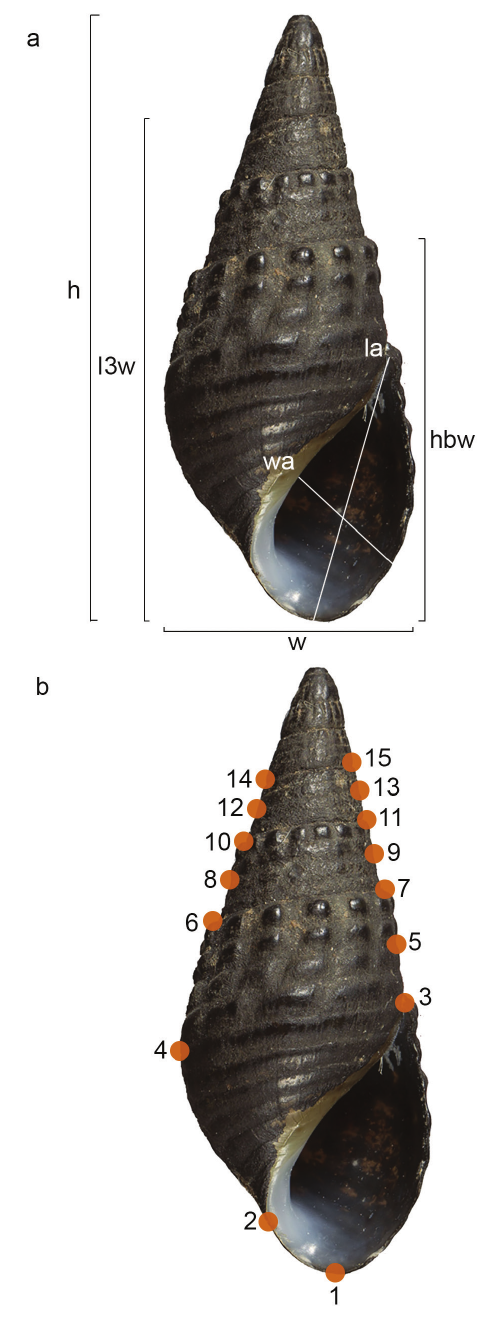
Figure 3. Biometrical parameters ( a ) and position of landmarks ( b ). Abbreviations: height of shell (h), width of shell (w), length of aperture (la), width of aperture (wa), height of body whorl (hbw) and height of last three whorls